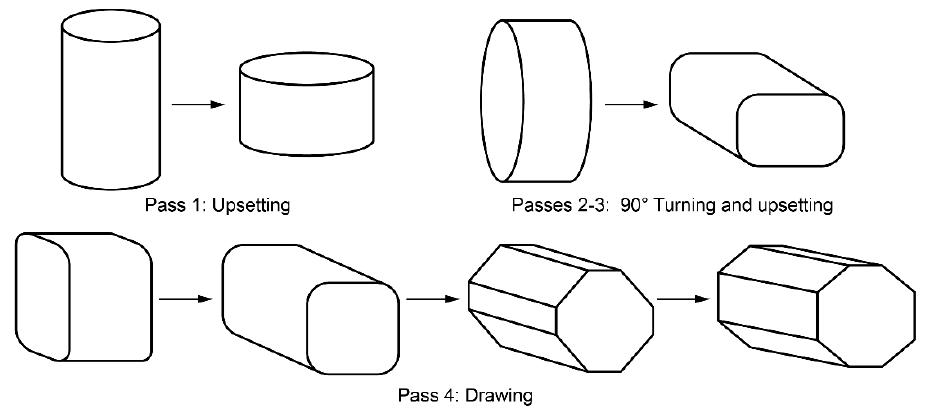
Figure 1. Schematics of the multi-axial forging cycle.